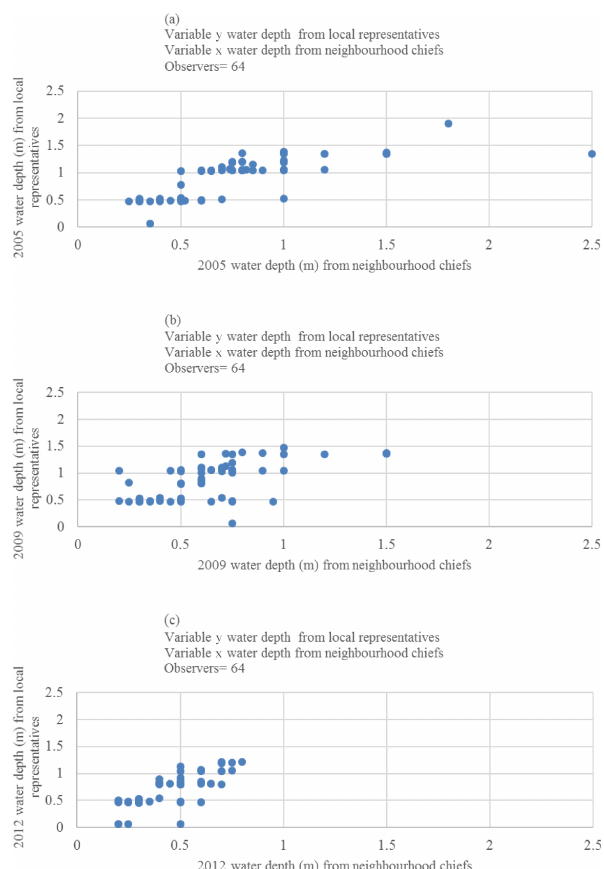
Figure 6. Scatter diagram of water depth information provided by techniques used with neighbourhood chiefs and local representa- tives for three different flooding events in (a) 2005, (b) 2009 and (c)